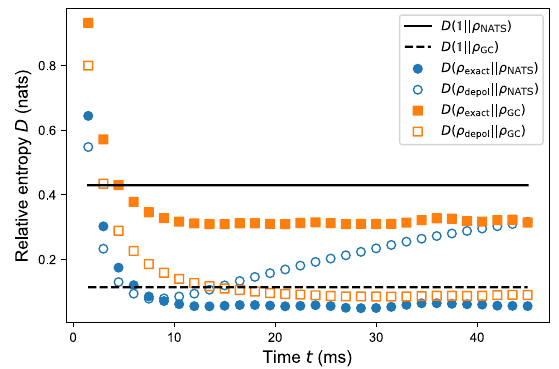
FIG. 4. Relative entropies from simulations with and without depolarizing noise versus time. We simulate 12 qubits subject to Trotterized Heisenberg evolution alone (filled markers) or with depolarization (empty markers). The blue circles show relative- entropy distances to the NATS and the orange squares show distances to the grand canonical